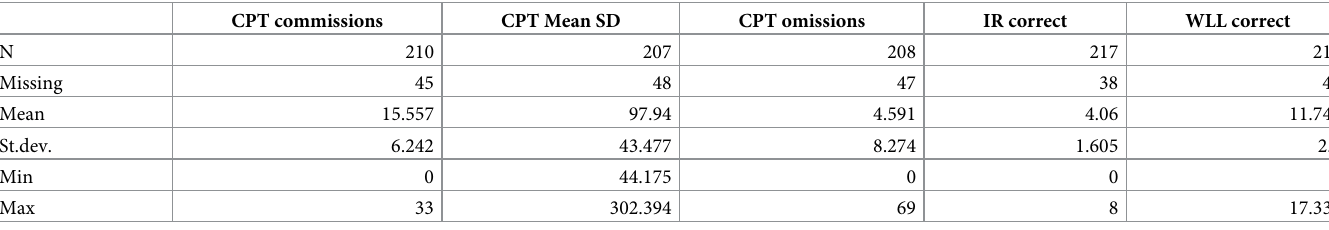
As estimated by Cronbach’s alpha coefficients, internal reliability of the EPELI variables was high over the ten task blocks: Total Score α = .878; Task efficacy α = .807; Navigation Efficacy Table 4. Performance in CPT and the episodic memory